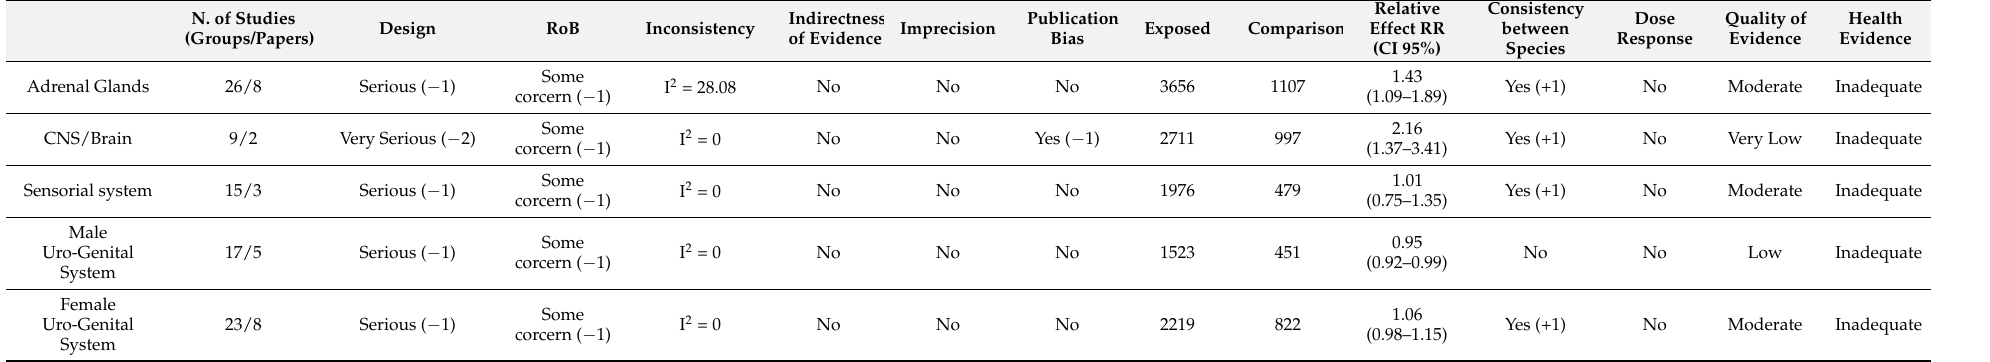
Table 11. Quality Assessment for the results on benign tumors in selected